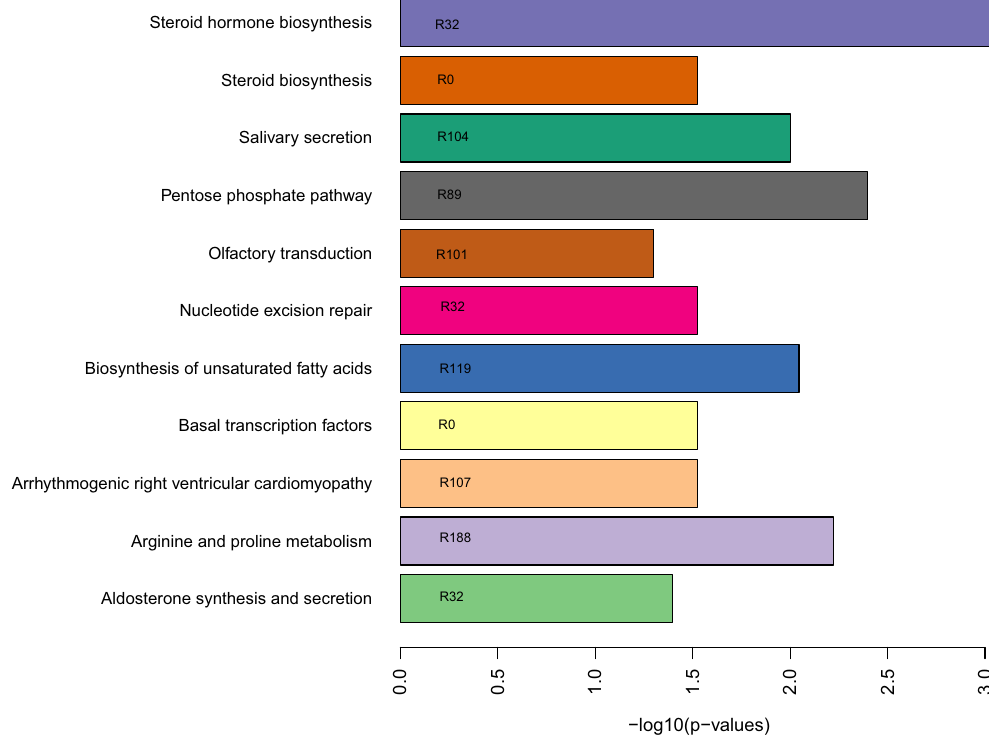
Figure 5. Biological pathways (y-axis) from Kyoto Encyclopedia of Genes and Genomes (KEGG) database that are significantly (FDR < 0.05, x-axis) enriched in SNPs sets from 8 out of the 29 most distinct genotype-lipidome relations. Text within the bars represent the relation (R) identification numbers in which the corresponding biological pathways were